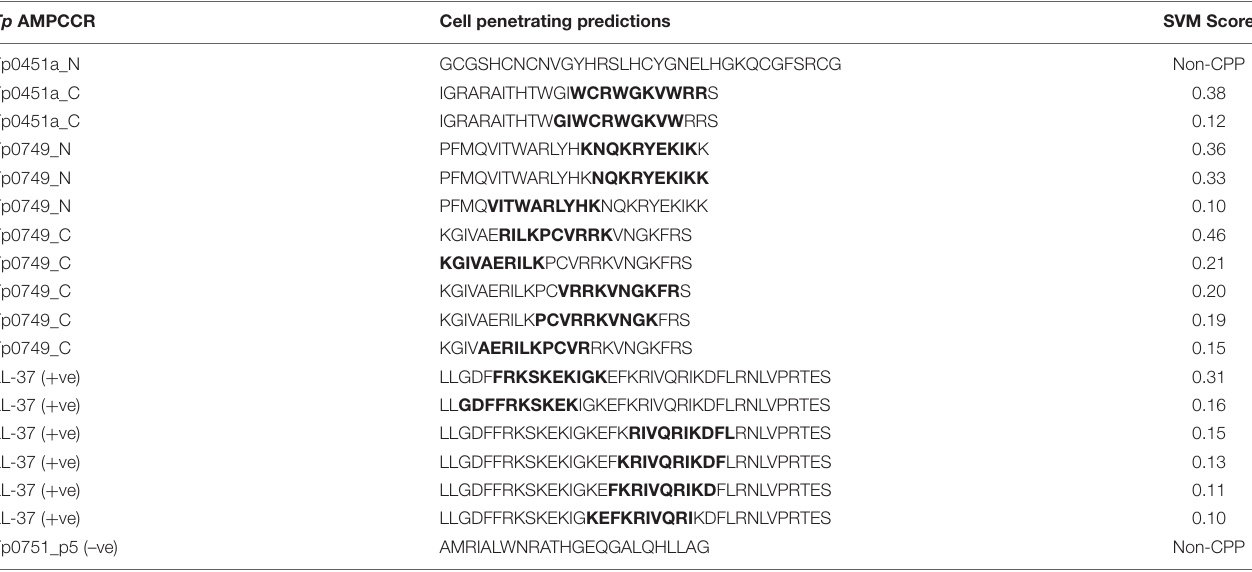
The four candidate AMPCCRs from T. pallidum were analyzed for amino acid sequence similarity with established, experimentally-validated AMPs using homology searches in the APD3 database. Tp, Treponema pallidum; AA, amino acid. TABLE 3 | Treponema pallidum candidate AMPCCRs with predicted cell penetrating